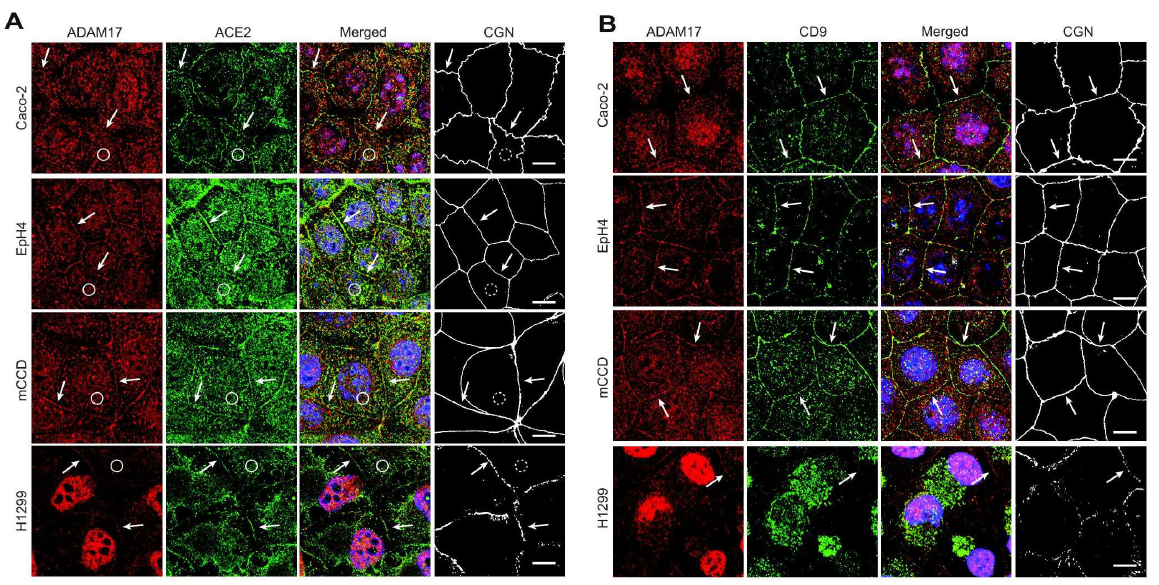
Figure 3. ACE2, ADAM17 and CD9 are localized at apical junctions of cultured epithelial cells. ( A , B ) Immunofluorescent microscopy localization of ADAM17, ACE2 and cingulin (CGN) ( A ), ADAM17, CD9 and CGN ( B ) in the indicated cell types (Caco2, Eph4, mCCD and H1299 cells). Arrows indicate junctional localization, circles indicate apical surface labeling, and dashed circles indicate a lack of apical cingulin labeling. CGN is used as an apical junctional reference marker. Bar = 10 microns.